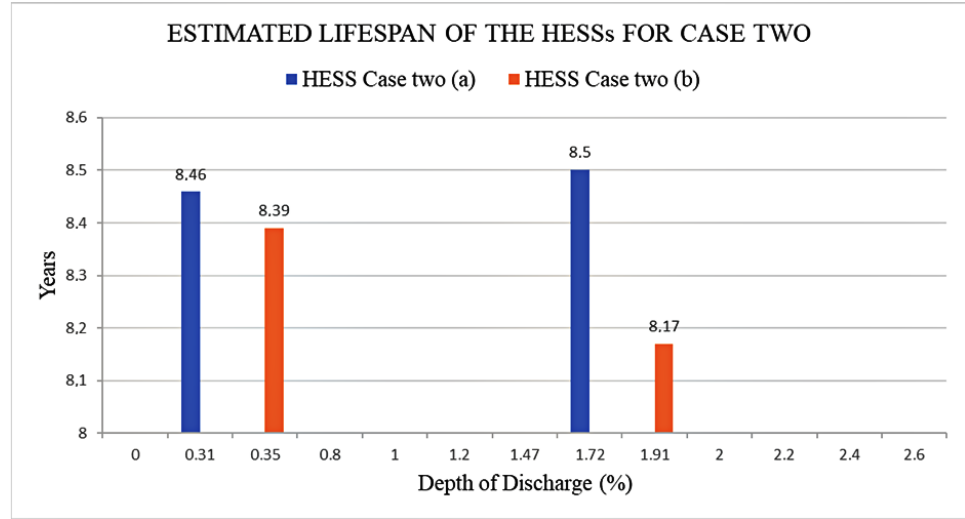
Figure 24. The estimated lifespan of Case two (a) versus Case two